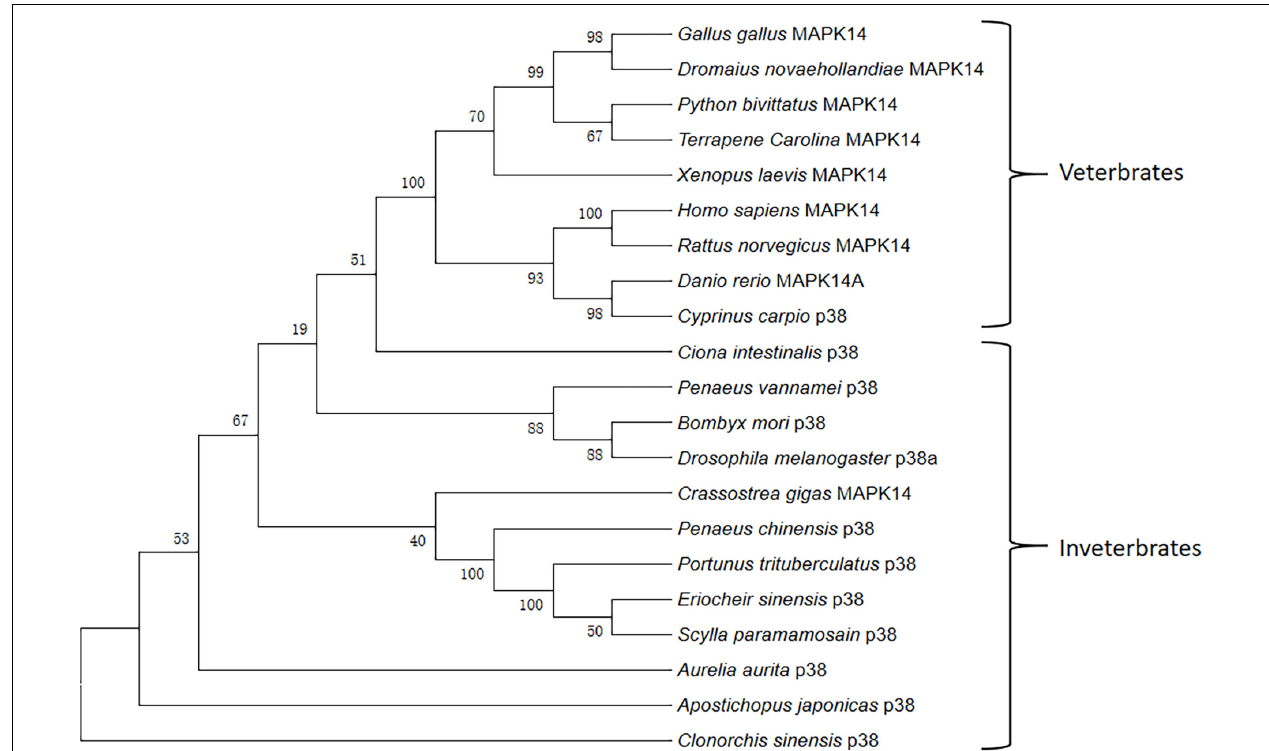
FIGURE 3 | Phylogenetic relationships of PtP38 and representative P38s from other species. The phylogenetic tree of P38 protein was constructed by the neighbor-joining method using the MEGA5.1 software. PtP38 has the closest relationship to Scylla Paramamosain , followed by Eriocheir sinensis . The GenBank login number is as follows: Homo sapiens MAPK14 (NP_001306.1); Gallus MAPK14 (XP_001232616.1); Python bivittatus MAPK14 (XP_007426614.1); Xenopus laevis MAPK14 (NP_001080300.1); Danio rerio MAPK14A (NP_571797.1); Eriocheir sinensis P38 (AII32447.1); Scylla paramamosain P38 (AHH29322.1); Crassostrea gigas MAPK14 (EKC29510.1); Aurelia aurita P38 (ARJ54259.1); Dromaius novaehollandiae MAPK14 (XP_025967659.1); Terrapenecarolina triunguis MAPK14 (XP_024066297.1); Ciona intestinalis P38 (NP_001071958.1); Clonorchis sinensis P38 (GAA55102.1); Apostichopus japonicas P38 (ASU91381.1); Penaeus chinensis P38 (AIY23112.1); Penaeus vannamei P38 (AGG82488.1); Bombyx mori P38 (NP_001036996.1); Drosophila melanogaster P38a (NP_477163.1); Cyprinus carpio P38 (BAA96415.1); Rattus norvegicus MAPK14